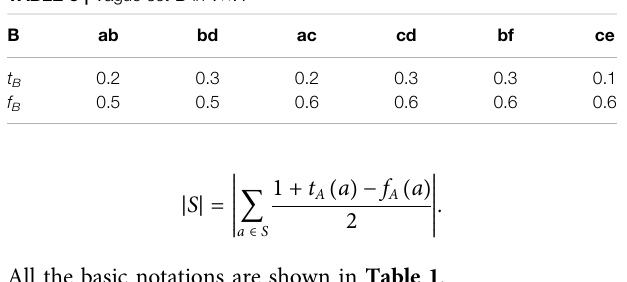
TABLE 3 | Vague set B in V × V .